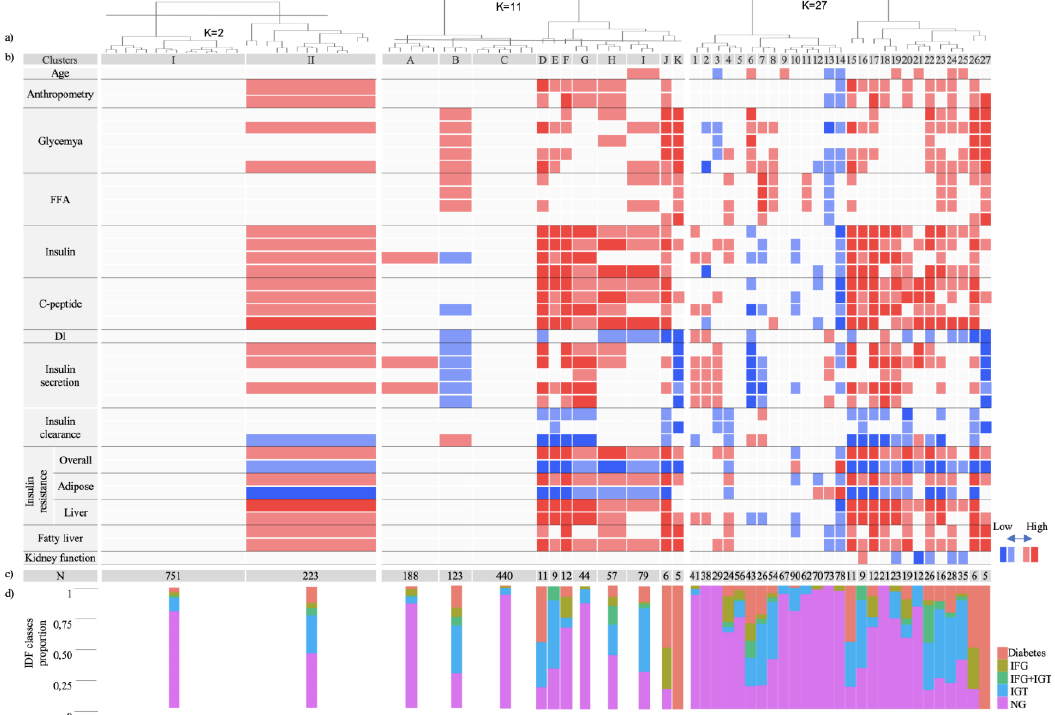
Figure 2. Clusters profiling. The dendogram of the hierarchical clustering of the 27 SOM units is shown for three cut levels of the dendogram ( a ): K = 2 (Cluster-I and -II); K = 11 (Clusters A–K); and K = 27 (Clusters 1–27). For each level, the clusters were profiled with several parameters, herein grouped by function, and the median of each cluster was compared with the distribution of the overall population (percentiles 10th, 25th, 75th, and 90th), and are displayed with a heatmap scale ( b ). Number of subjects in each cluster is shown in ( c ). Distribution of dysglycemia classes (IDF) in each cluster is shown in ( d ). DI-Disposition Index; FFA-Free fatty acids; IDF-International Diabetes